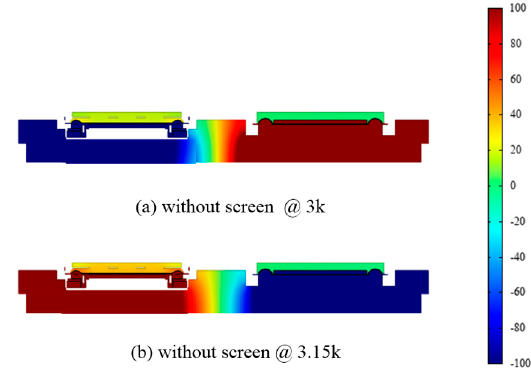
Figure 8. Sound pressure distribution (without screen).